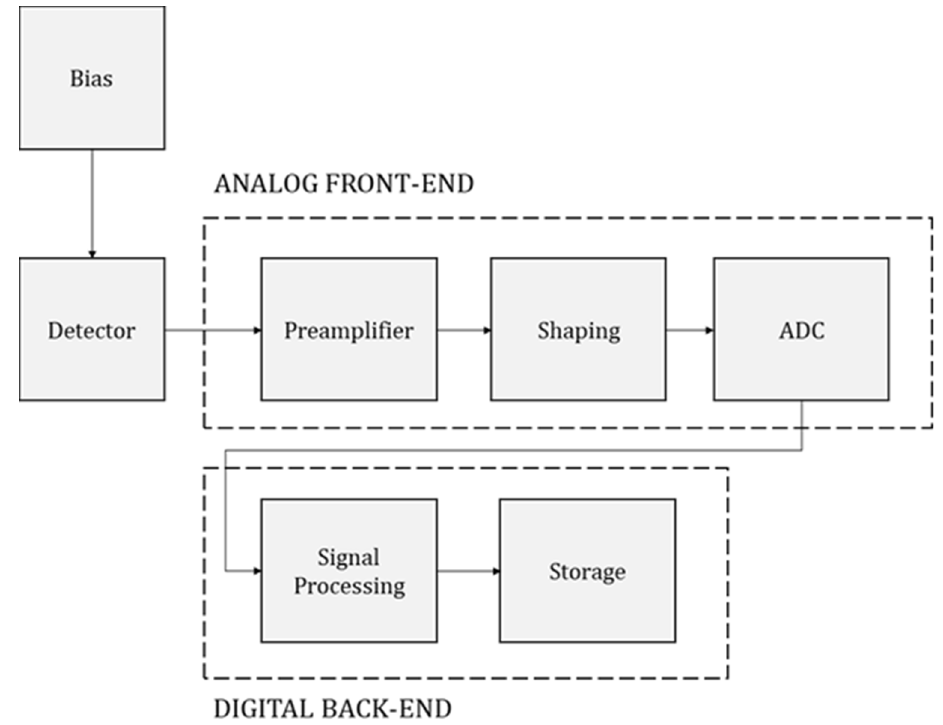
Figure 1. General scheme of a PDFE.